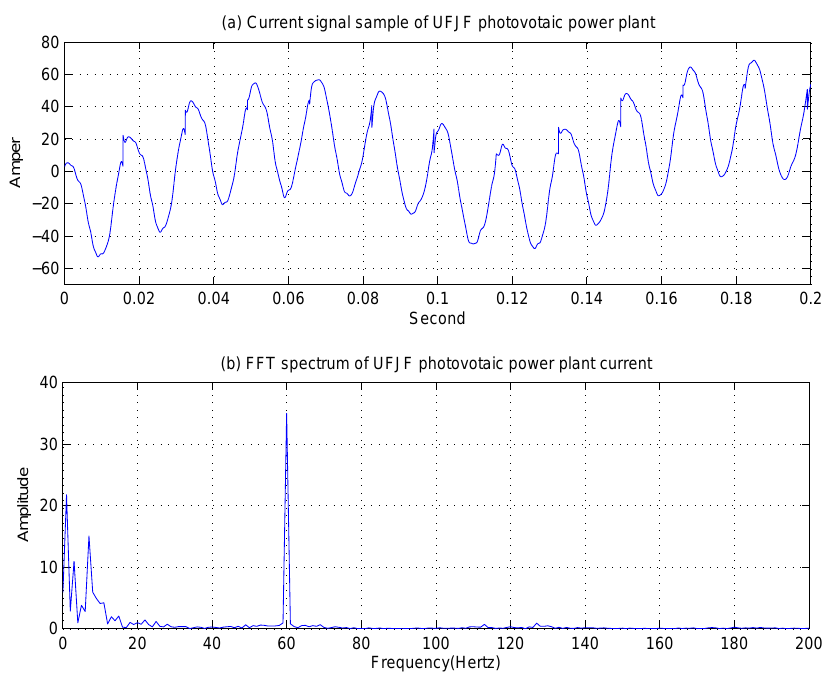
Figure 17. ( a ) Two hundred milliseconds of the PV signal measured from the UFJF PV power plant and its ( b ) FFT spectrum with colored interference in the frequency range of [0–20]